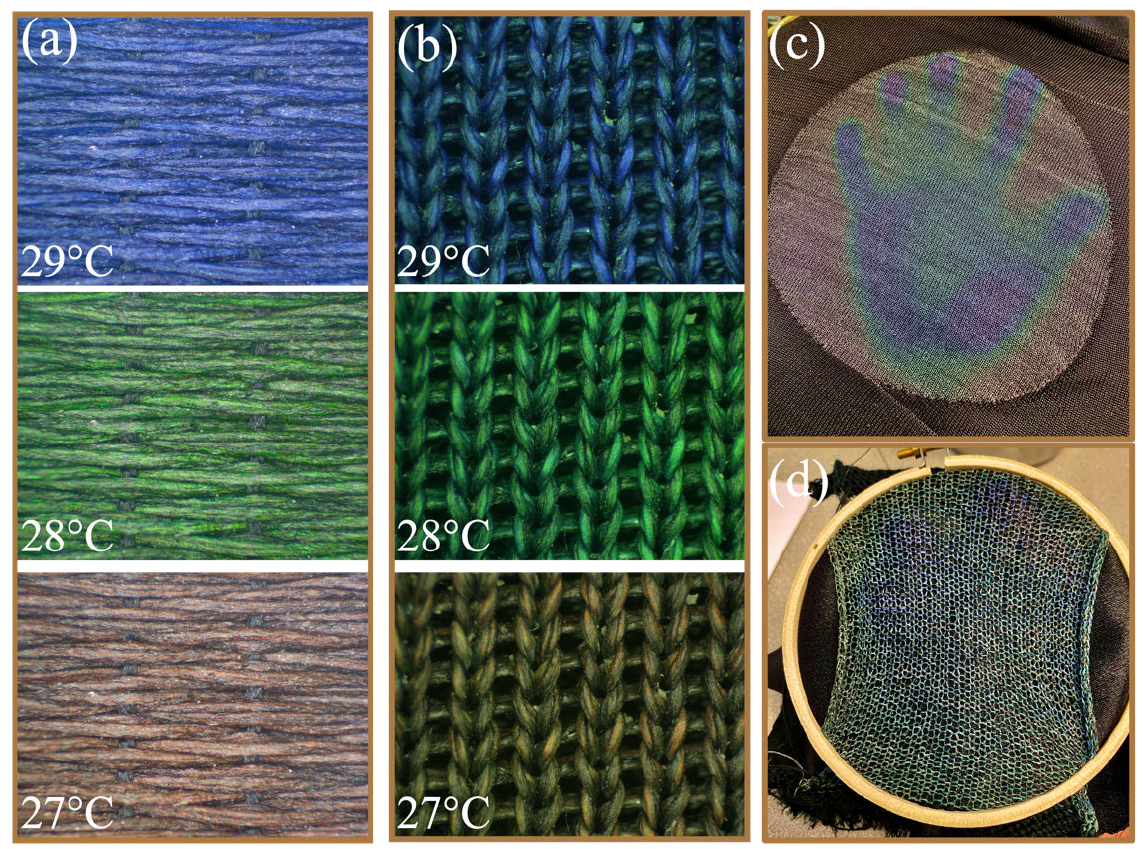
Figure 4. Images of hand woven ( a ) and knitted ( b ) fabrics of SFXC LC coated polyester yarns. ( c ) Machine knitted fabric with black satin fabric underlay revealing the hand placed underneath the fabric. ( d ) Handknitted fabric showing temperature inhomogeneity.